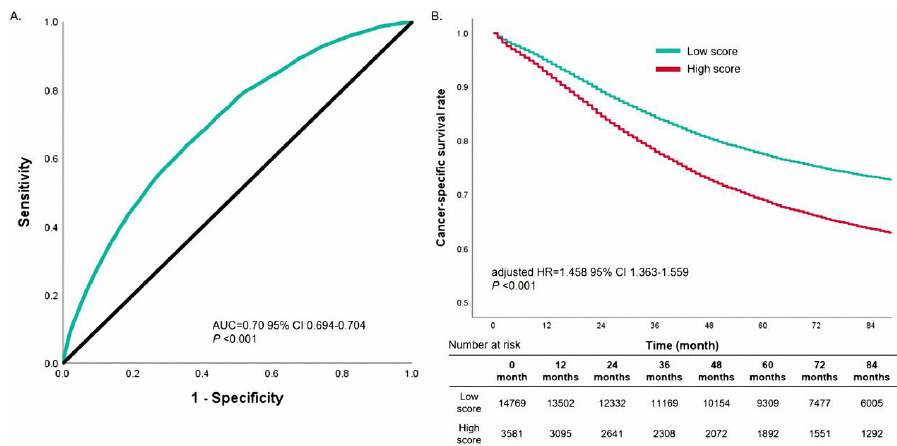
Figure 4. Receiver operating characteristic curve analysis for the sensitivity and specificity of the nomogram system to predict lymph node metastasis (N1/N2 stage) ( A ). Stratified effect of the nomogram ( B ). Table 3. Multivariable Cox regression for cancer-specific mortality in patients with N0 classification after